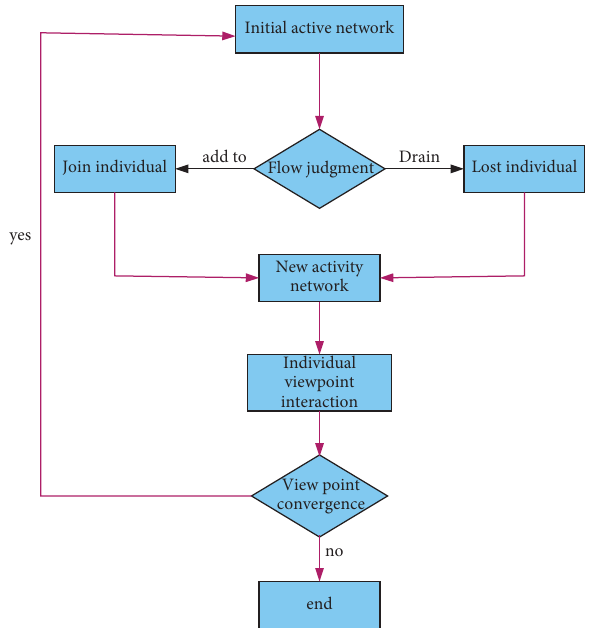
Figure 4: Network public opinion opinion aggregation